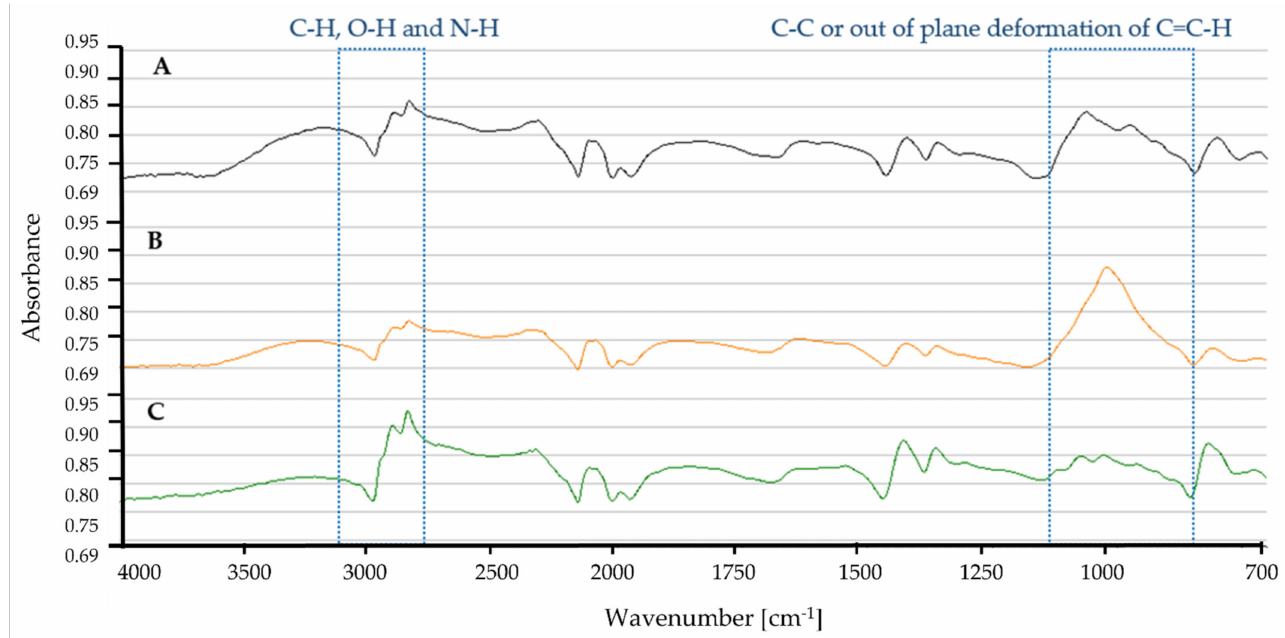
Figure 10. ATR-FTIR profile for tyre granules as carbon source in MSM broth for 30 days, 28 ◦ C, 180 rpm ( A ) Control ( B ) Dactylosporangium sp. AC04546 ( C ) Microtetraspora sp.